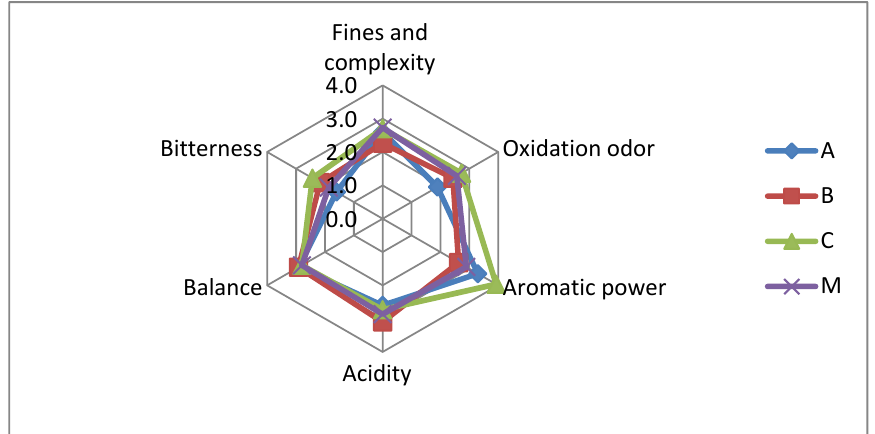
Figure 4. Radar results of the qualitative sensorial parameters for the three inoculated wines (A, B, and C) and the wine that fermented spontaneously (M).